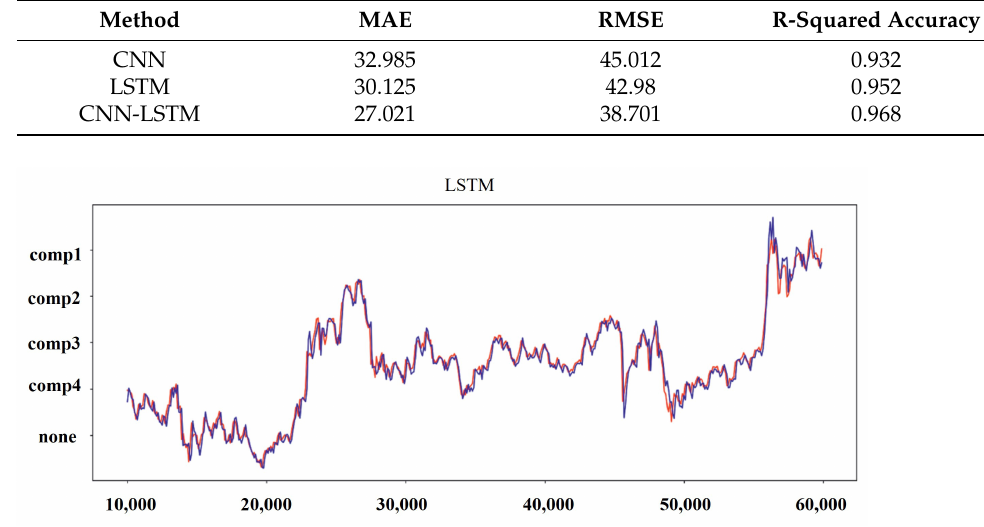
Figure 10. Results for predicted and real values for LSTM.